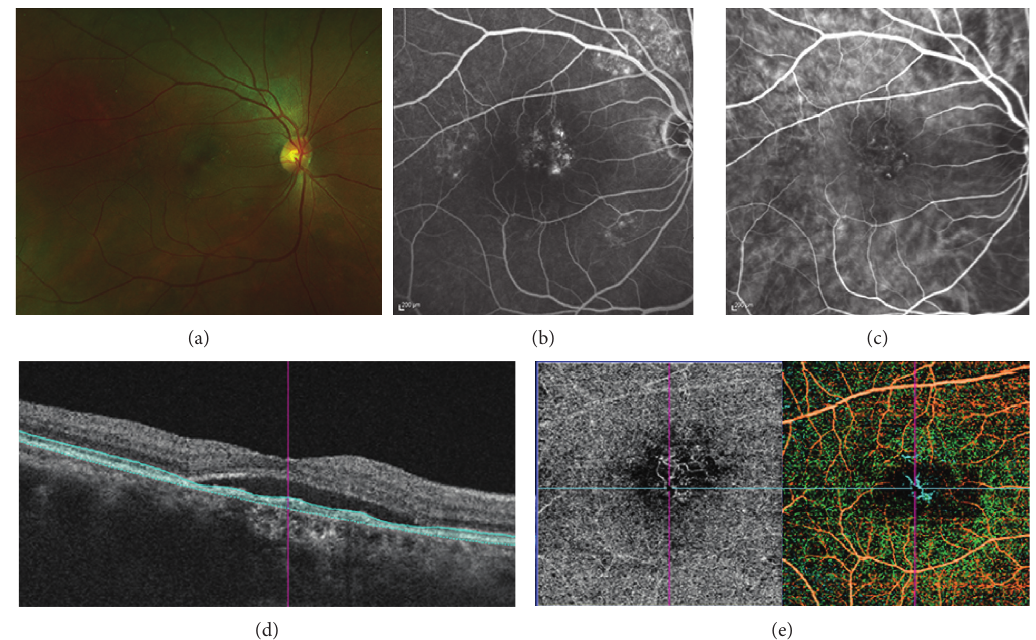
Figure 1: Diagnosis of polypoidal choroidal vasculopathy (PCV) in a case of central serous chorioretinopathy. Subretinal fluid is demonstrated with fundus photograph (a). Multifocal leakage is seen in fluorescein angiography (b). Polypoidal lesions and branching vascular network (BVN) are seen in indocyanine green angiography (c). Optical coherence tomography (OCT) does not show specific feature of PCV (d). BVN, but not polypoidal lesions, can be seen in OCT angiography